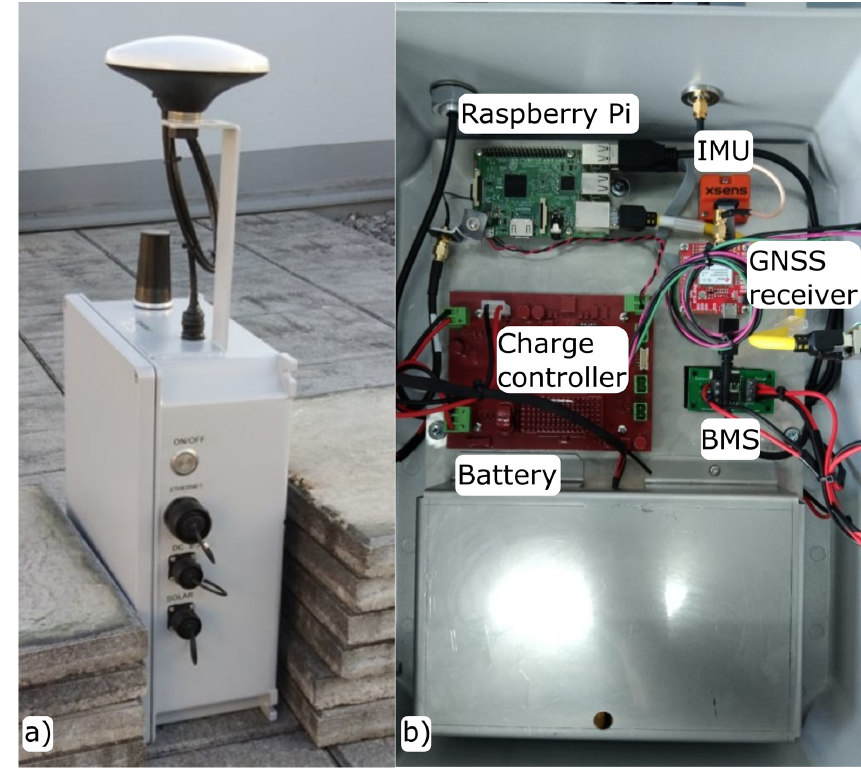
Figure 3. Smart sensor ( a ) waterproof housing and ( b ) internal view.